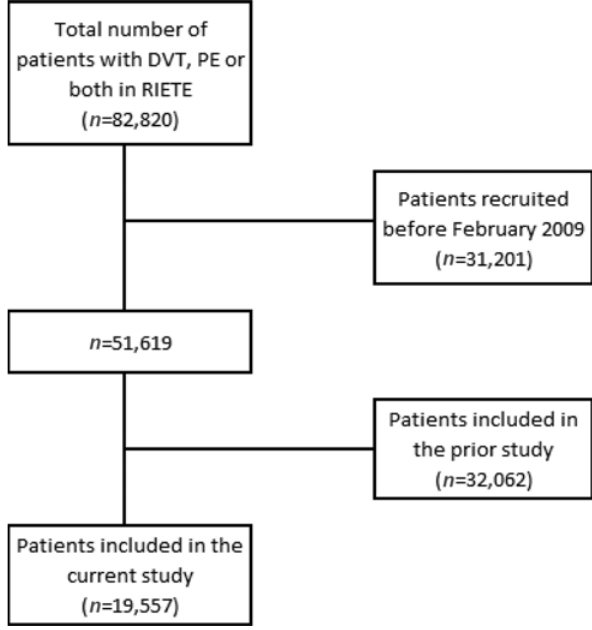
Fig. 1 Patients with VTE who were recruited in Registro